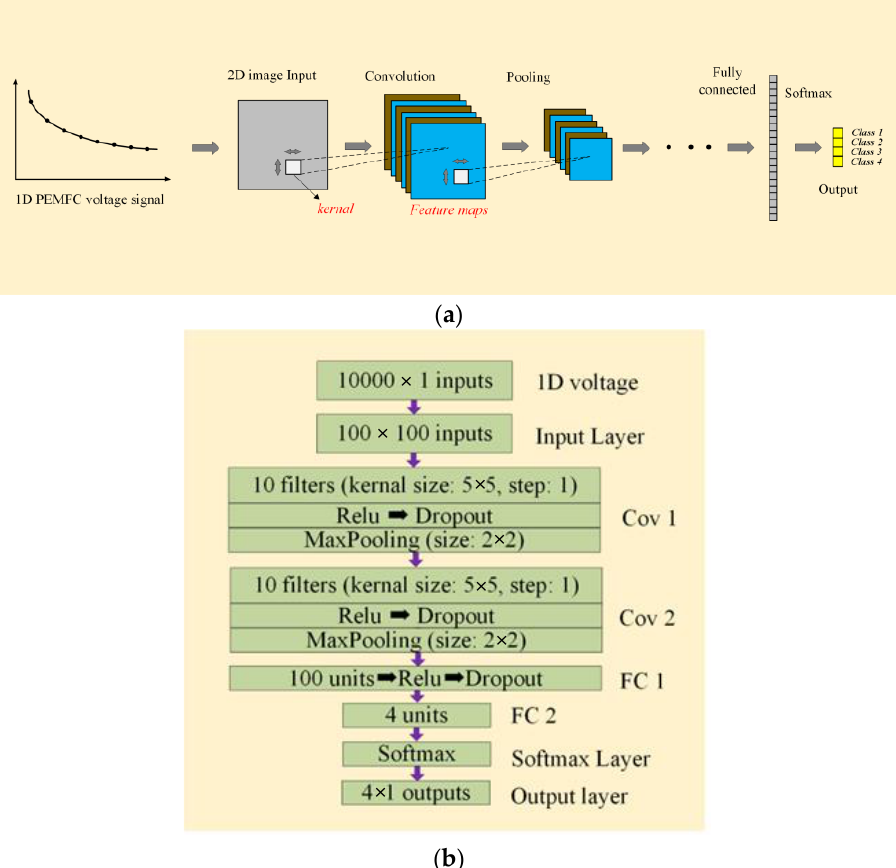
Figure 3. ( a ) Structure of the 2D-CNN model. ( b ) Parameters of the 2D-CNN model.